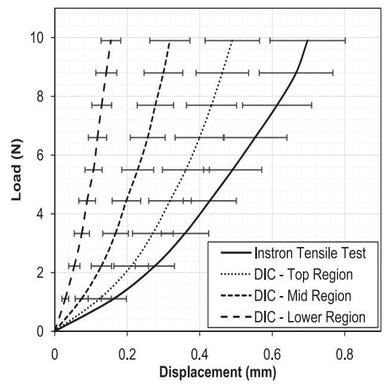
Representative average load-displacement curves at different regions across the surface of the anterior cruciate ligament during a tensile test. Curves for the top, middle (mid) and lower regions obtained from the image correlations using 3D digital image correlation setup and the tensile test on the material testing machine curve obtained from the moving crosshead of the material testing machine. The error bars represent specimen variations (n = 5), the maximum.